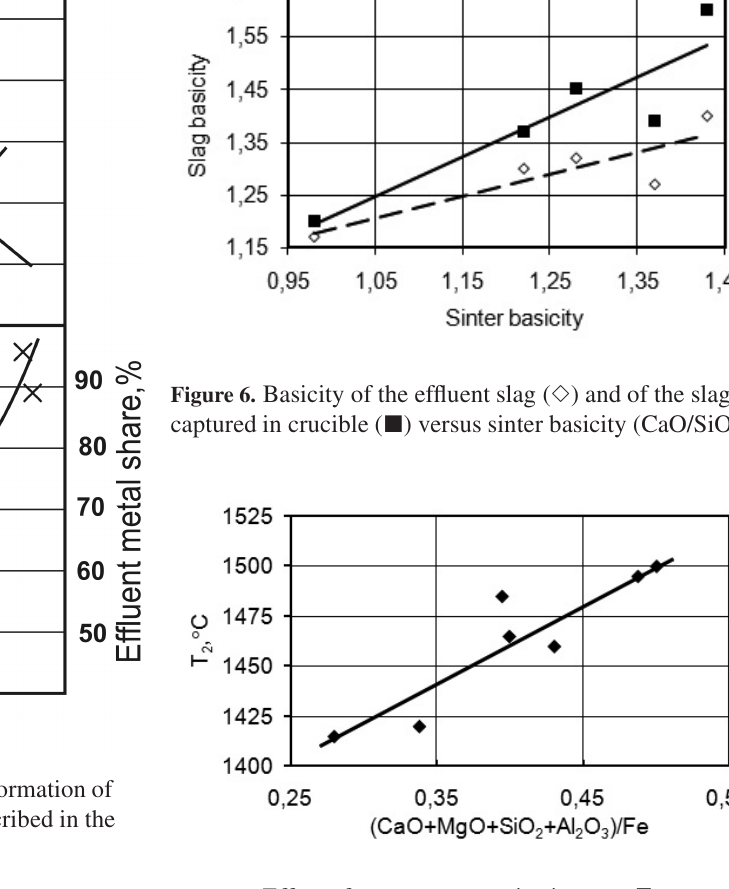
Figure 7. Effect of gangue amount in sinter on T 2